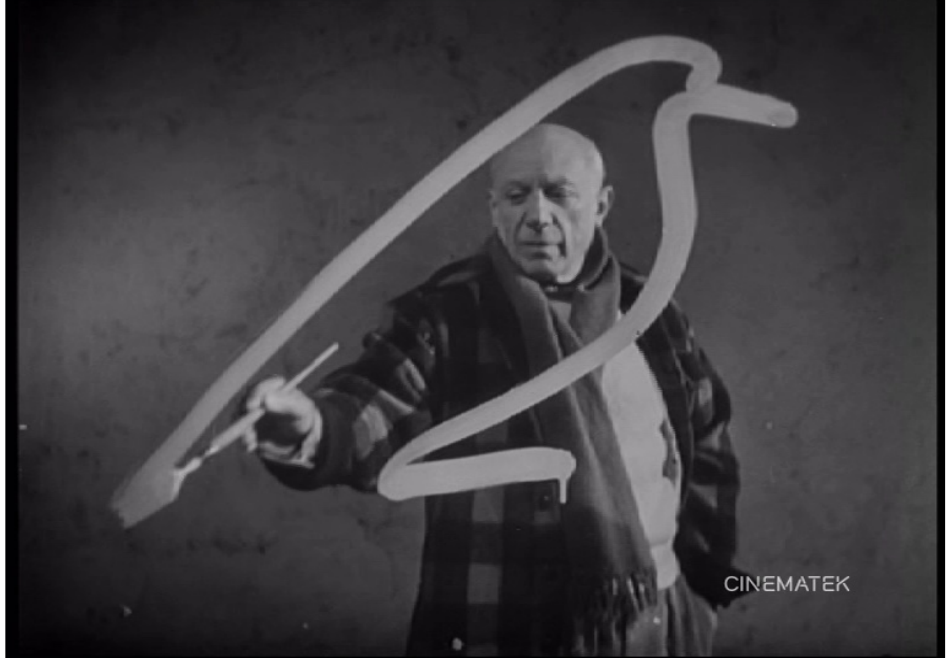
Figure 3. Paul Haesaerts, Visite à Picasso , 1950 (digital film frame).